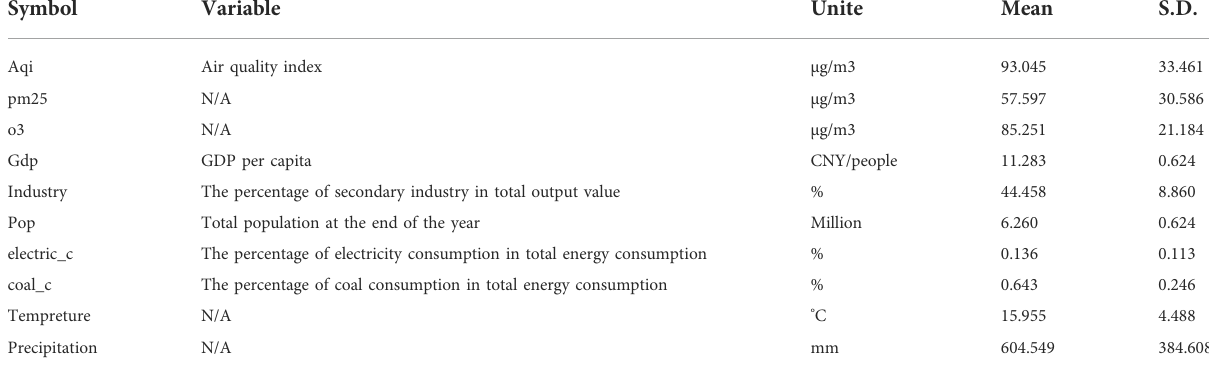
TABLE 1 Summary statistics of the